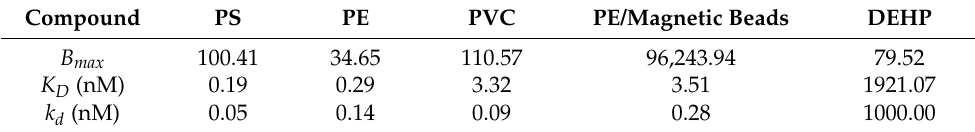
Table 1. Affinity of estrogen-like compounds to estrogen receptor.